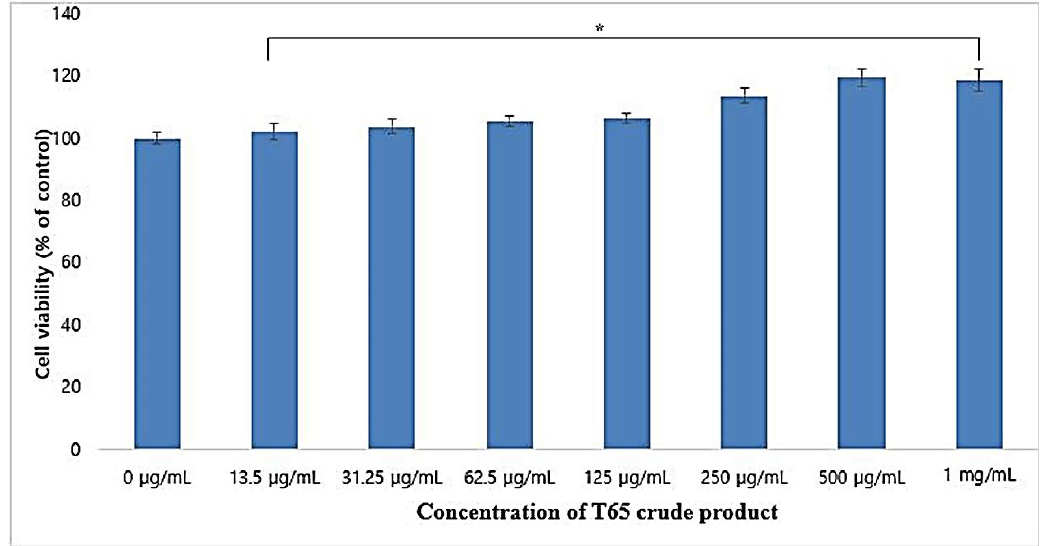
Figure 1. Assessment of cytotoxicity of T65 crude product in RAW264.7 cells. Values are given as mean ± SEM (standard error of the mean). * p < 0.05 compared to control.